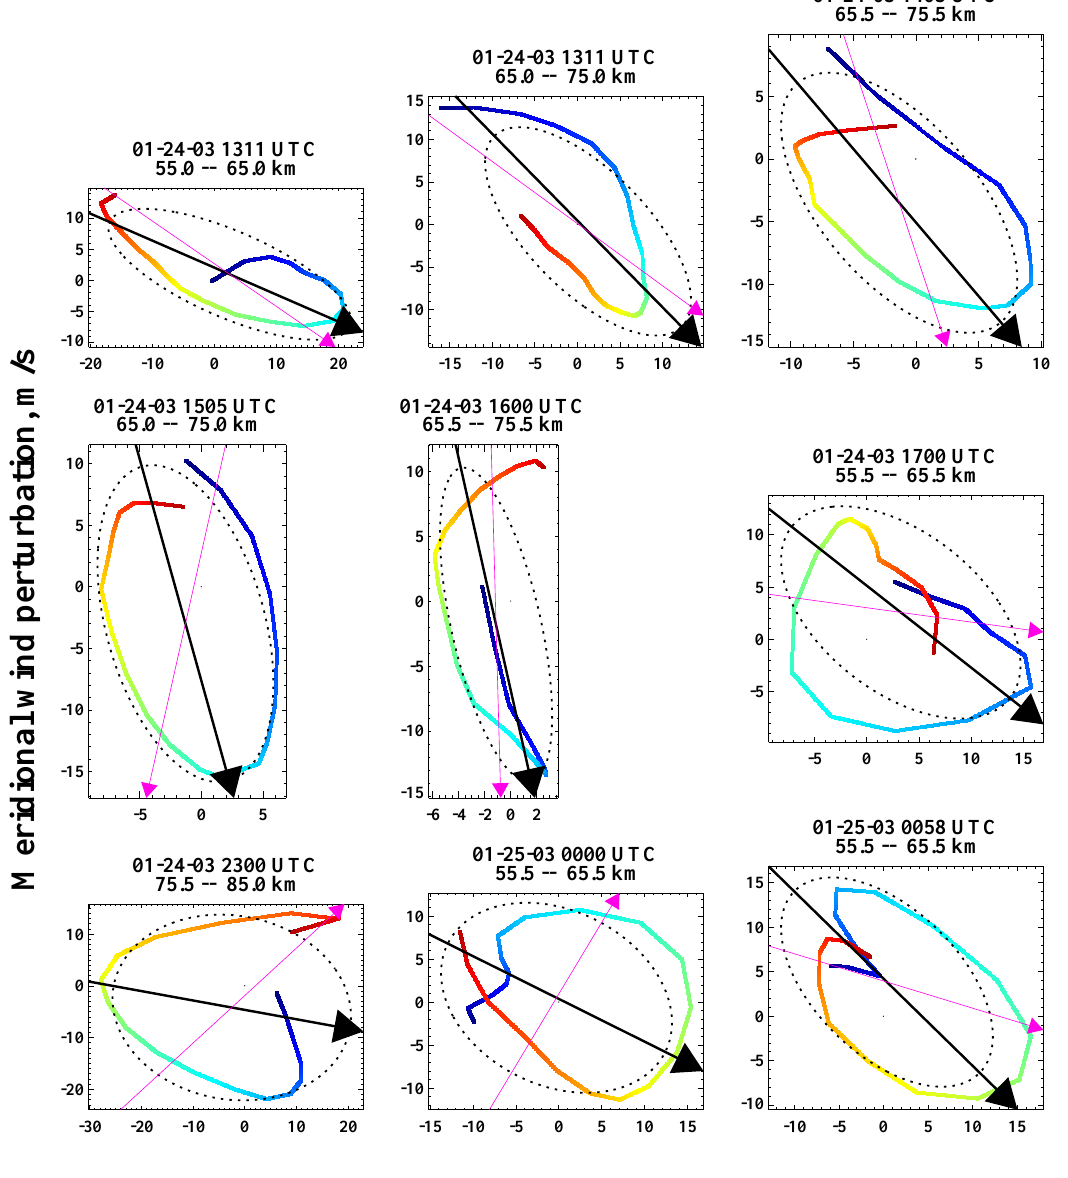
Fig. 7. Gravity wave perturbation hodographs (the thick colored lines) and the derived horizontal propagation directions for FS Salvo 1 at 60km and above. The lowest altitude is denoted by blue color, whereas the highest altitude is denoted by red color. The thin dark dotted ellipse is the fit from the S-transform approach. The thick dark arrow denotes the direction estimated from the new approach. The thin pink arrow denotes the direction estimated from the Stokes parameter analysis. Ordering is chronological and then by increasing altitude. See text for